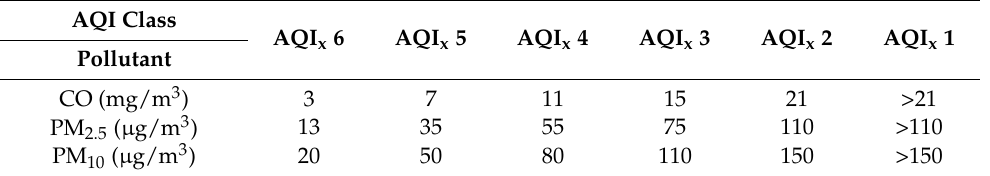
Table 2. The air quality index classes, concerning maximum hourly average concentration of CO, PM 2.5 and PM 10 [36].